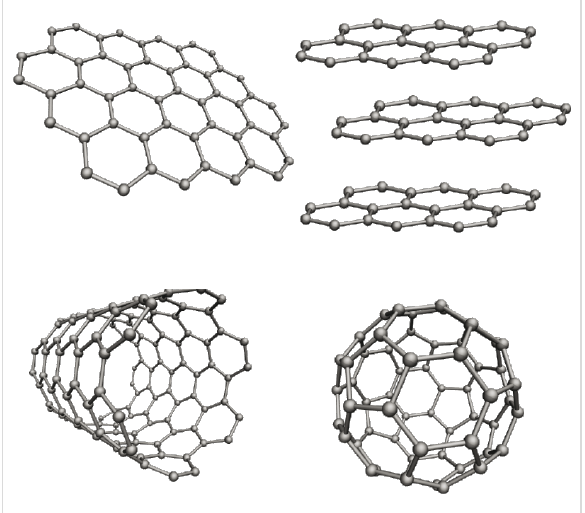
Figure 1: Structural models of graphitic carbon nanomaterials. Clock- wise from top left: graphene, graphite, C 60 fullerene, and a single- walled carbon